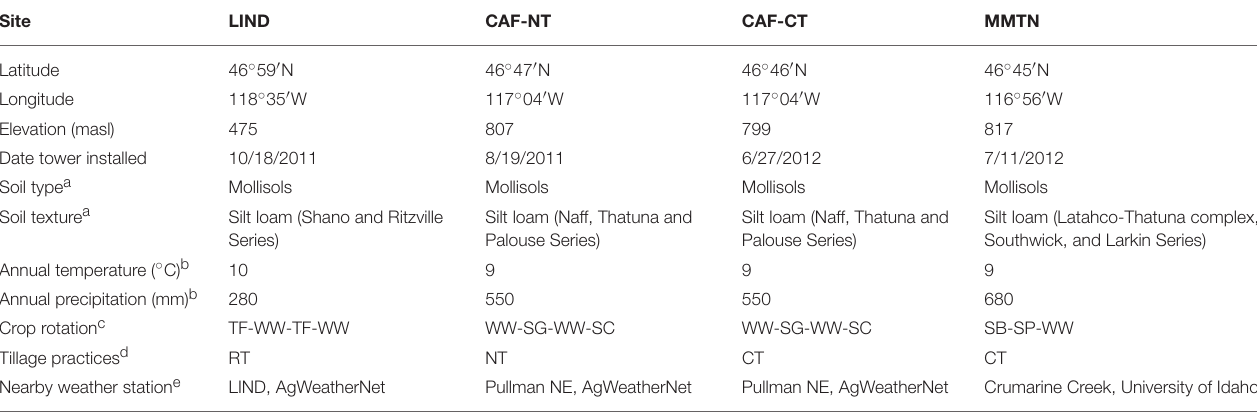
TABLE 1 | Site characteristics, local meteorology, and management practices at each